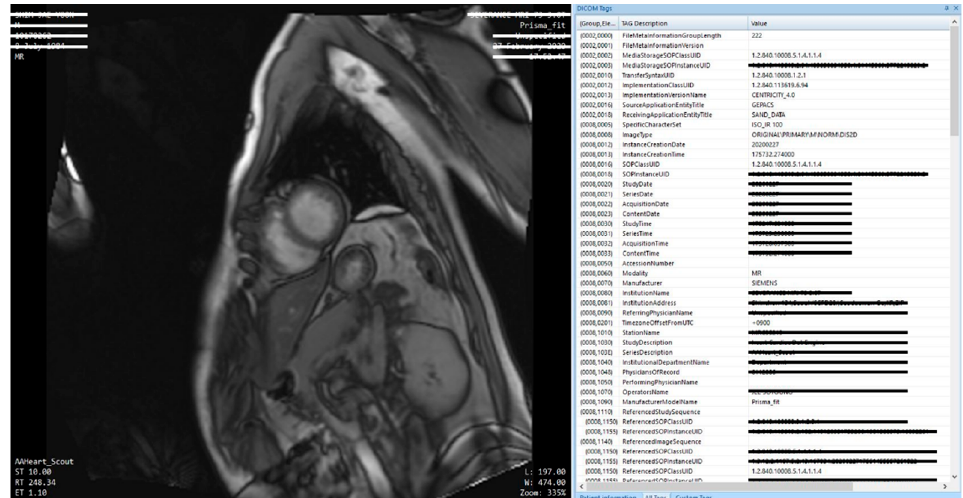
Figure 10. Original Cardiovascular MRI Imaging.